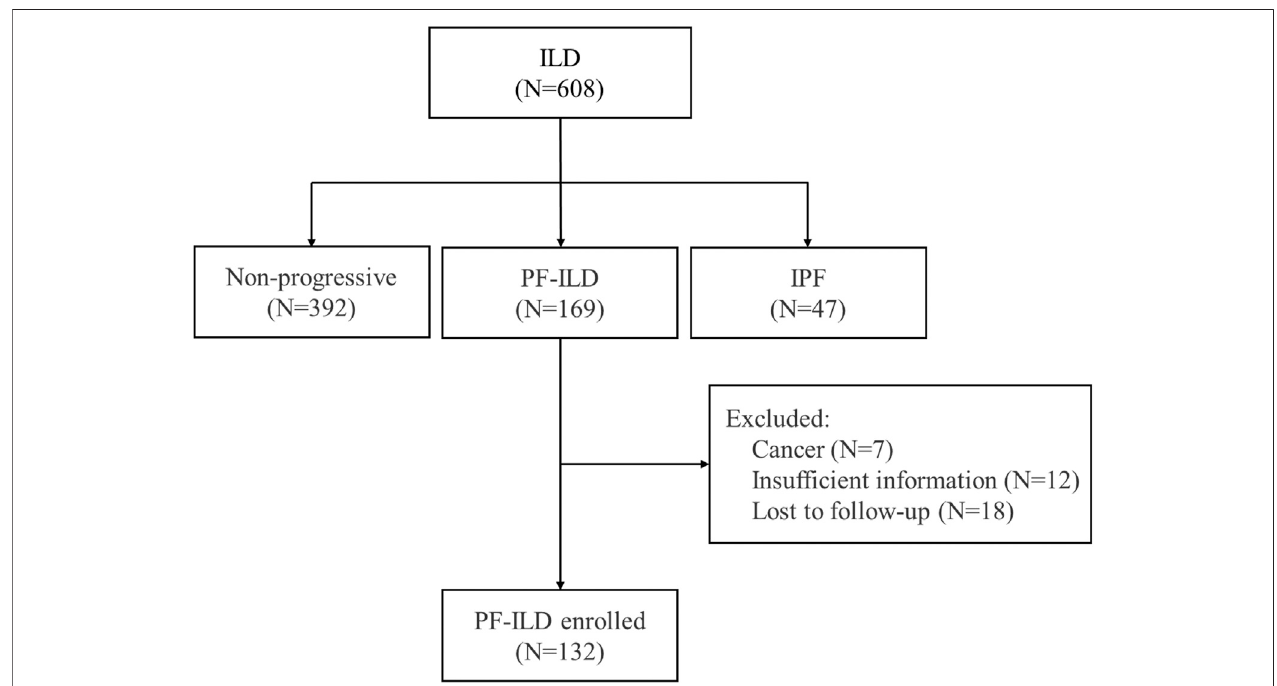
FIGURE 1 | Flow chart of enrollment; Abbreviation: PF-ILD, progressive fi brosing interstitial lung disease; IPF, idiopathic pulmonary fi brosis.